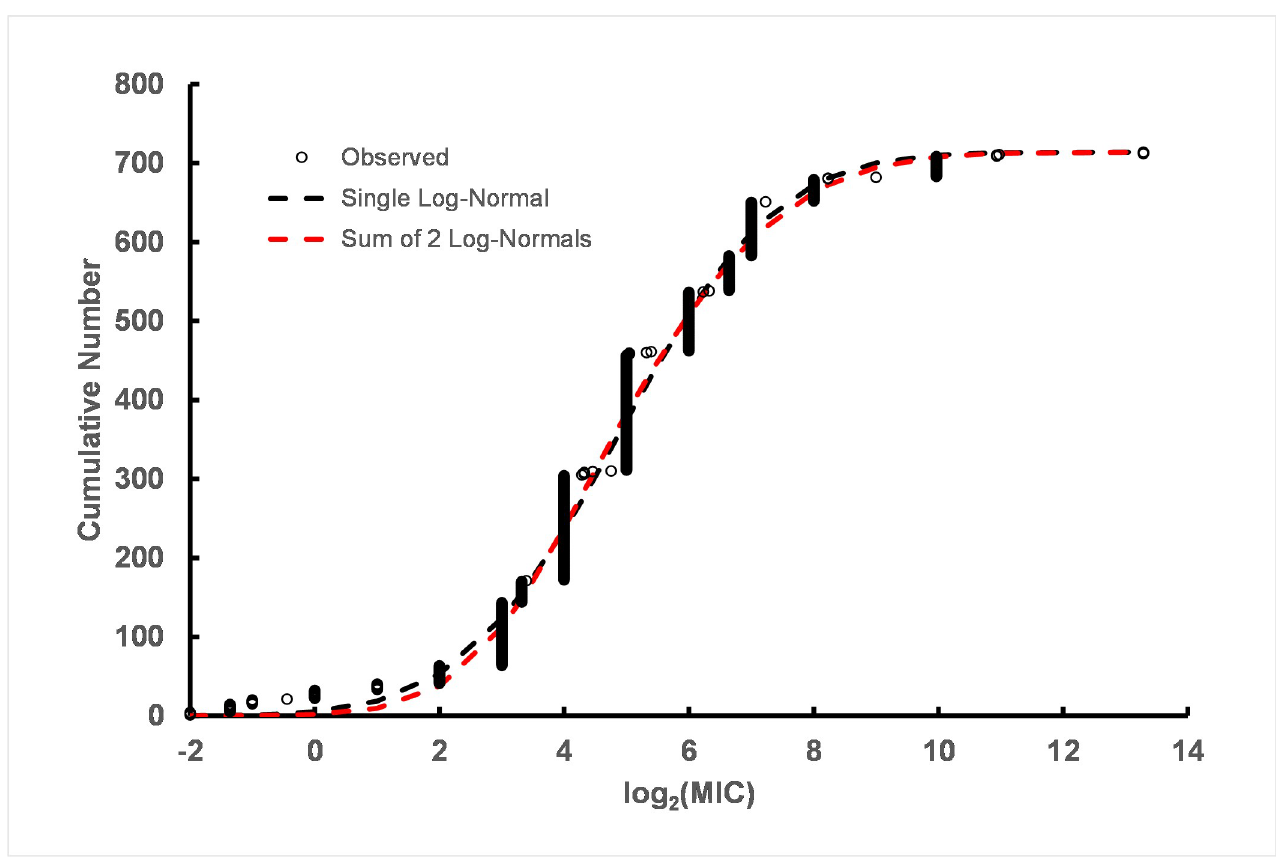
Fig 5. Comparison of fits by single and sum of two log-normal cumulative distribution functions to pooled K . pneumoniae data. The improved fit of the sum of two log-normal distributions compared to a single log-normal was indicated by differences in AIC ranging from 11 to 68 and p-values for the F-test ranging from 1 x 10 − 5 to 1 x 10 − 3 . See S6 Table in S2 Appendix for details.